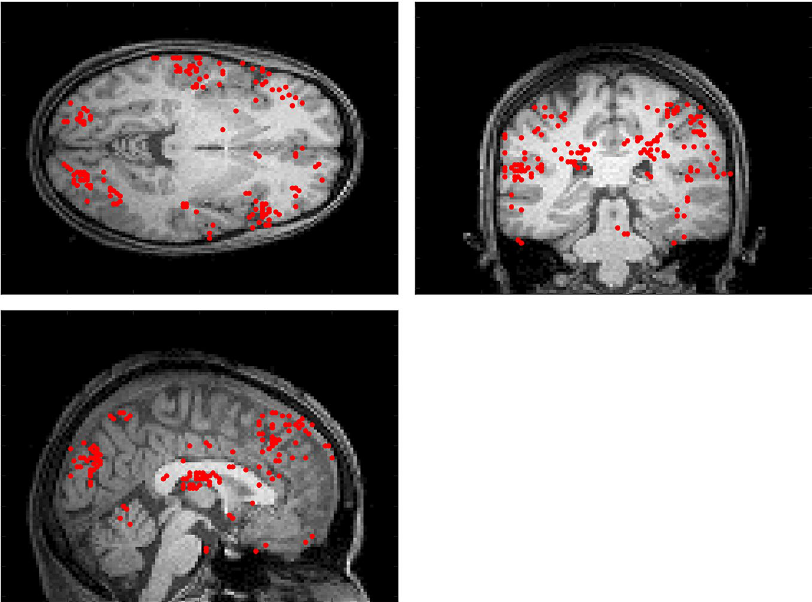
Figure 2. Locations of the 4 dipole locations chosen for each fold of the 3 × 3 cross fold validation scheme for each participant and overlaid on a standard T1-weighted image projected on the axial, coronal, and sagittal planes.